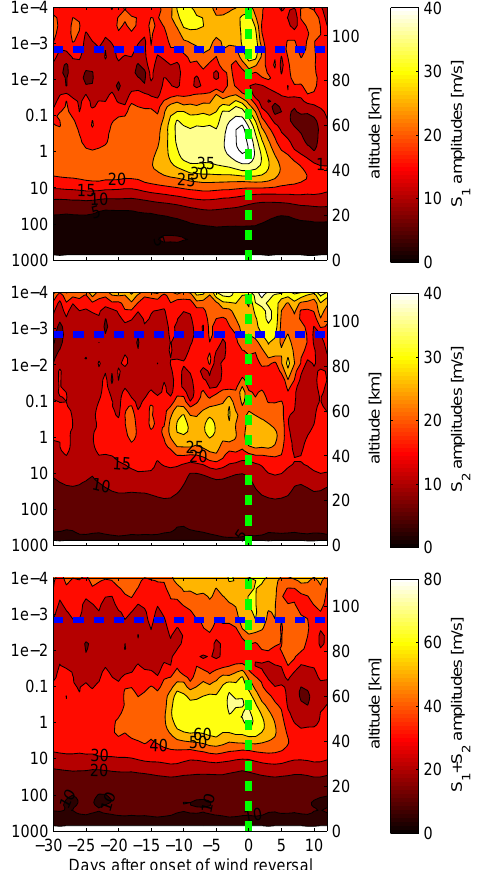
Figure 4. Composites of PW activity observed by SD-WACCM around SSW events for the S 1 (upper panel), the S 2 (middle panel) component and the sum of both components (lower panel) aver- aged over 48–65 ◦ N. The vertical green line marks the onset of the stratospheric wind reversal. The horizontal blue line marks the ap- proximate mean altitude of the SuperDARN wind observations.